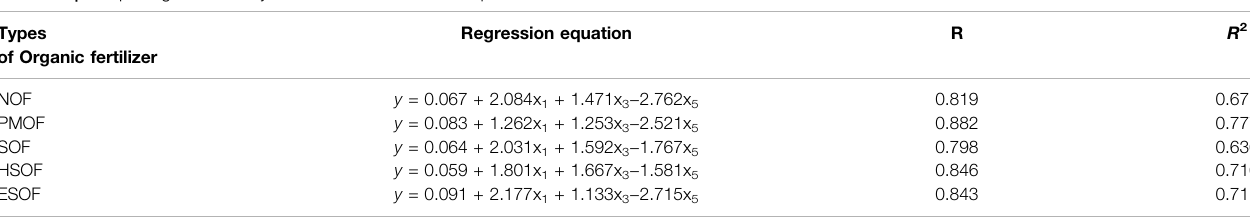
TABLE 4 | Multiple regression analysis of available Cd and Cd speciation. Types of Organic